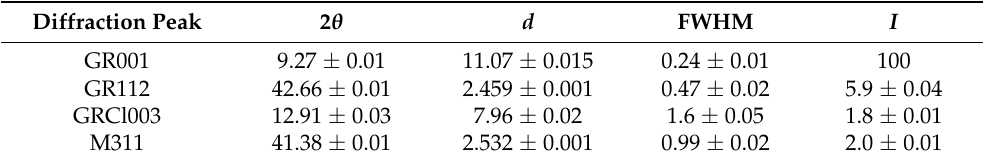
Figure 7. XRD pattern of the precipitate obtained with acetate after 1 week of ageing at RT. GR = GR(SO 42 − ), GRCl = GR(Cl − ), M = magnetite, with the corresponding Miller index. * = unidentified peaks. Table 5. Precipitate obtained with acetate and aged 1 week: characteristics of the diffraction peaks GR001 and GR112 of GR(SO 42 − ), GRCl003 of GR(Cl − ) and M311 of magnetite; 2 θ = diffraction angle, in degree, d = interplanar distance (Å), FWHM = full width a half maximum, in degree, and I = peak intensity, with I = 100 for GR001.